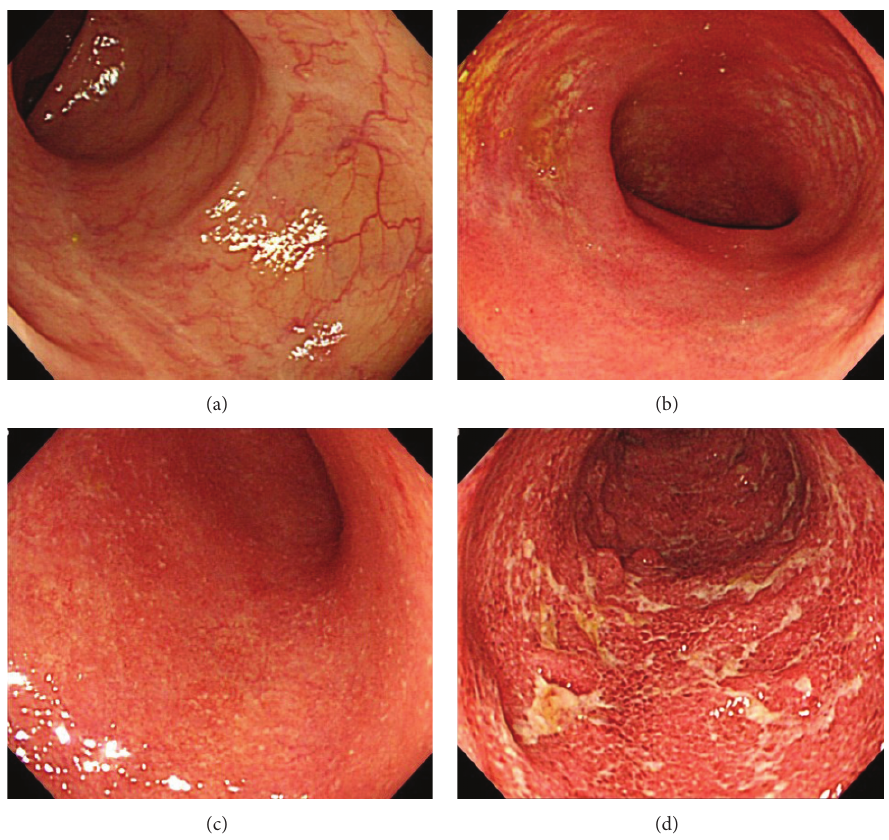
Figure 1: (a) An endoscopic image of the colonic mucosa, a Mayo endoscopic subscore of 0. The mucosal has a visible vascular pattern, and scattered white ulcer scars are evident. (b) An endoscopic image of the colonic mucosa, a Mayo endoscopic subscore of 1. The vascular pattern of the mucosa is decreased, with mild erythema. (c) An endoscopic image of the colonic mucosa, a Mayo endoscopic subscore of 2. The vascular pattern of the mucosa is decreased, with marked erythema and multiple erosions. (d) An endoscopic image of the colonic mucosa, a Mayo endoscopic subscore of 3. The mucosa shows marked erythema and ulcers.